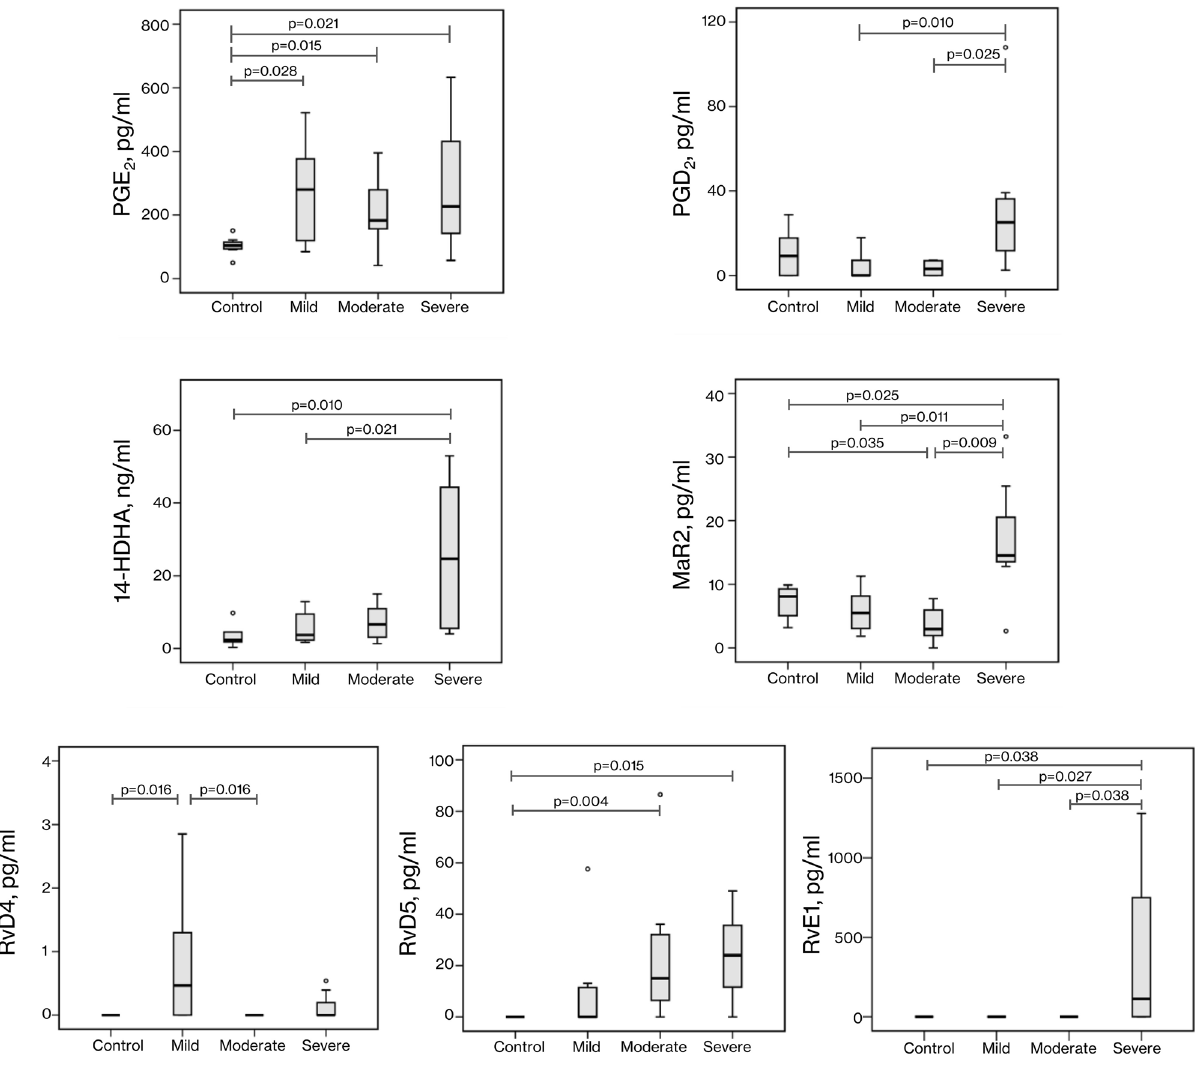
Figure 2. Serum levels of active lipid mediators and ω3-PUFAs differentially expressed in healthy controls or COVID-19 patients with different severity. COVID-19 patients were divided into three groups: mild, moderate, and severe pulmonary involvement. Panels represent concentrations of prostaglandin E 2 (PGE 2 ), prostaglandin D 2 (PGD 2 ), 14-hydroxy docosahexaenoic acid (14-HDHA), maresin 2 (MaR2), resolvin D4 (RvD4), resolvin D5 (RvD5), and resolvin E1 (RvE1), respectively, in mentioned groups. P -values were obtained by performing a Mann–Whitney U test. Only lipid mediators with P < 0.05 by Kruskal–Wallis test (Table 3) were